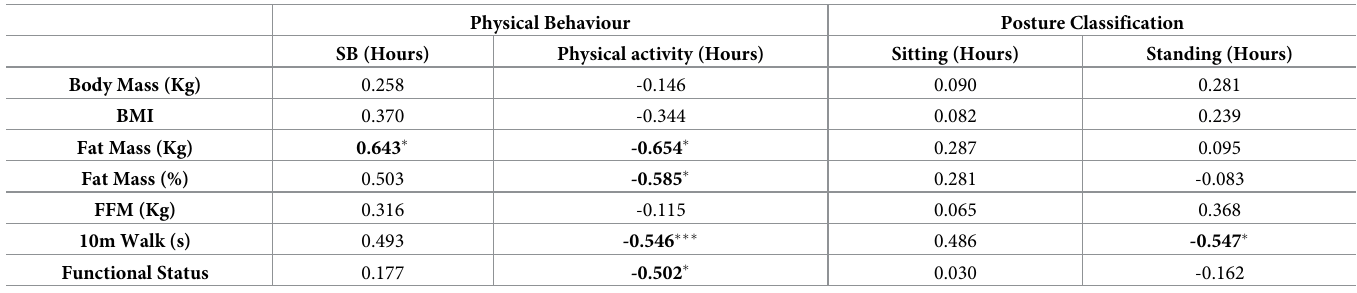
Table 3. Physical behaviour and posture classification associations with body composition and